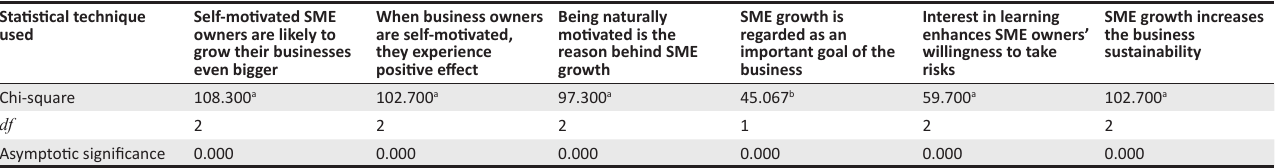
TABLE 3: Chi-square statistics for self-motivation of business owners for small and medium enterprise growth. Statistical technique used